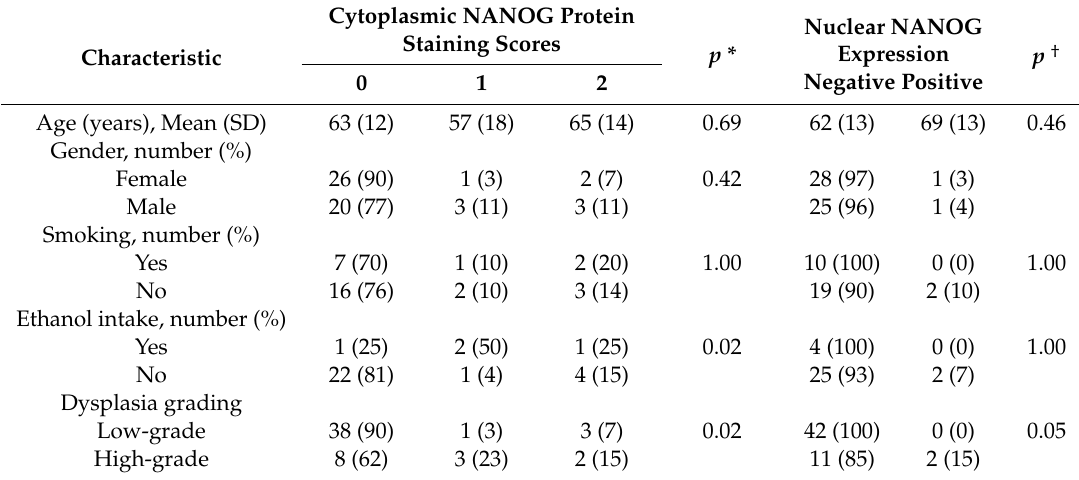
Figure 1. Immunohistochemical analysis of NANOG expression in oral epithelial dysplasias and oral squamous cell carcinoma (OSCC). The normal adjacent epithelium exhibited negative staining ( A ). Representative examples of oral dysplasias showing negative ( B ), and positive NANOG staining ( C ), human seminoma as a positive control ( D ). Examples of oral squamous cell carcinomas with positive ( E ), and negative NANOG staining ( F ). Magnification 200 × . Scale bar 200 µ m. Table 1. Associations between NANOG protein expression and clinicopathological features in patients with oral